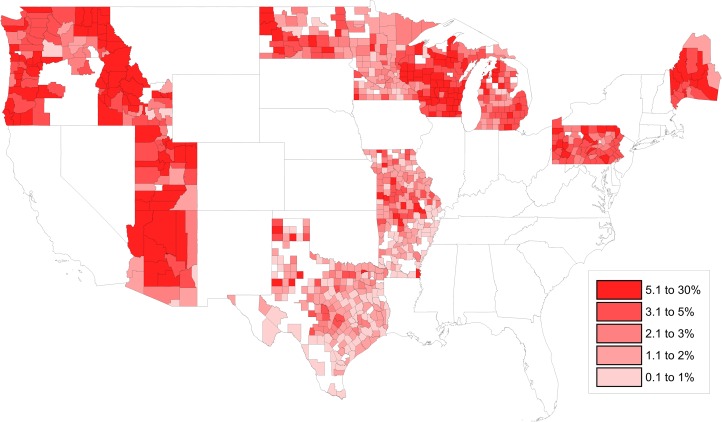
Heat map of county-level NME rates in 2016 to 2017.NME, nonmedical exemption.